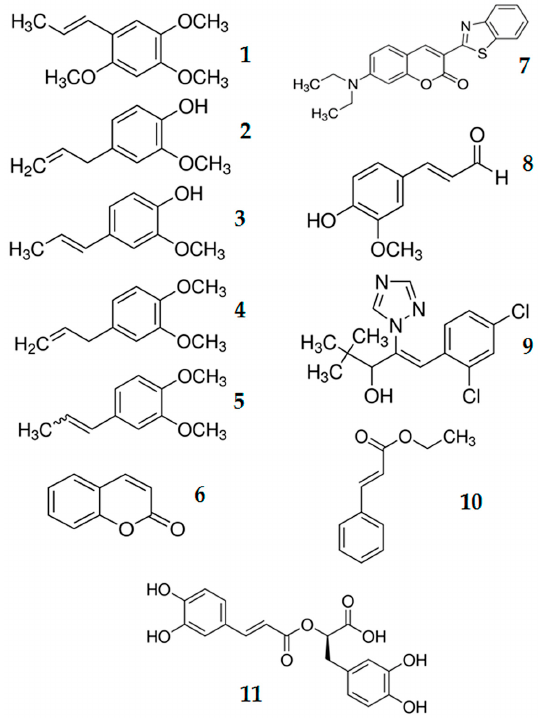
Figure 3. Chemical structures of α -asarone 1 , eugenol 2 , isoeugenol 3 , methyl eugenol 4 , methyl isoeugenol 5 , coumarin 6 , coumarin 6 7 , coniferyl aldehyde 8 , diniconazole 9 , ethyl cinnamate 10 , and rosmarinic acid 11 .